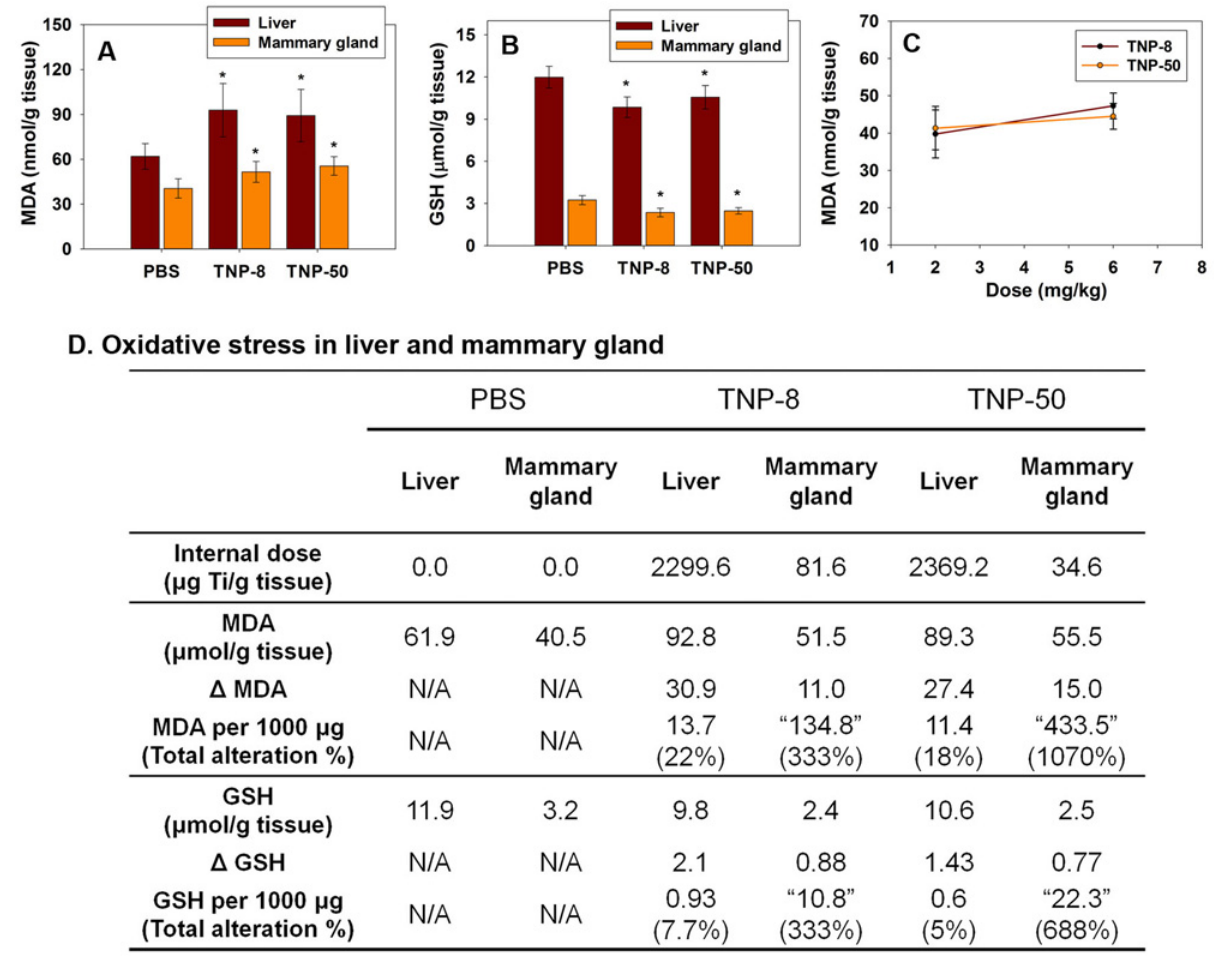
Fig 3. Determination of levels of MDA (A), GSH (B), Linear correlation between dose and MDA in mammary gland (C) and comparison of TNP generated oxidative stress in mammary glands and liver (D) at LD 10 after four doses of TNP exposures (8 mg/kg) at LDs 2, 4, 6 and 8. Seven mice in each group were examined. Data are mean ± s.d. (n = 7 per group). Values in "" are hypothetical values when the internal dose in mammary gland were 1000 μ g Ti/g tissue. The symbol * represents significant difference from the PBS group (P < 0.05). Δ MDA = (Liver MDA in TNP groups) – (Liver MDA in